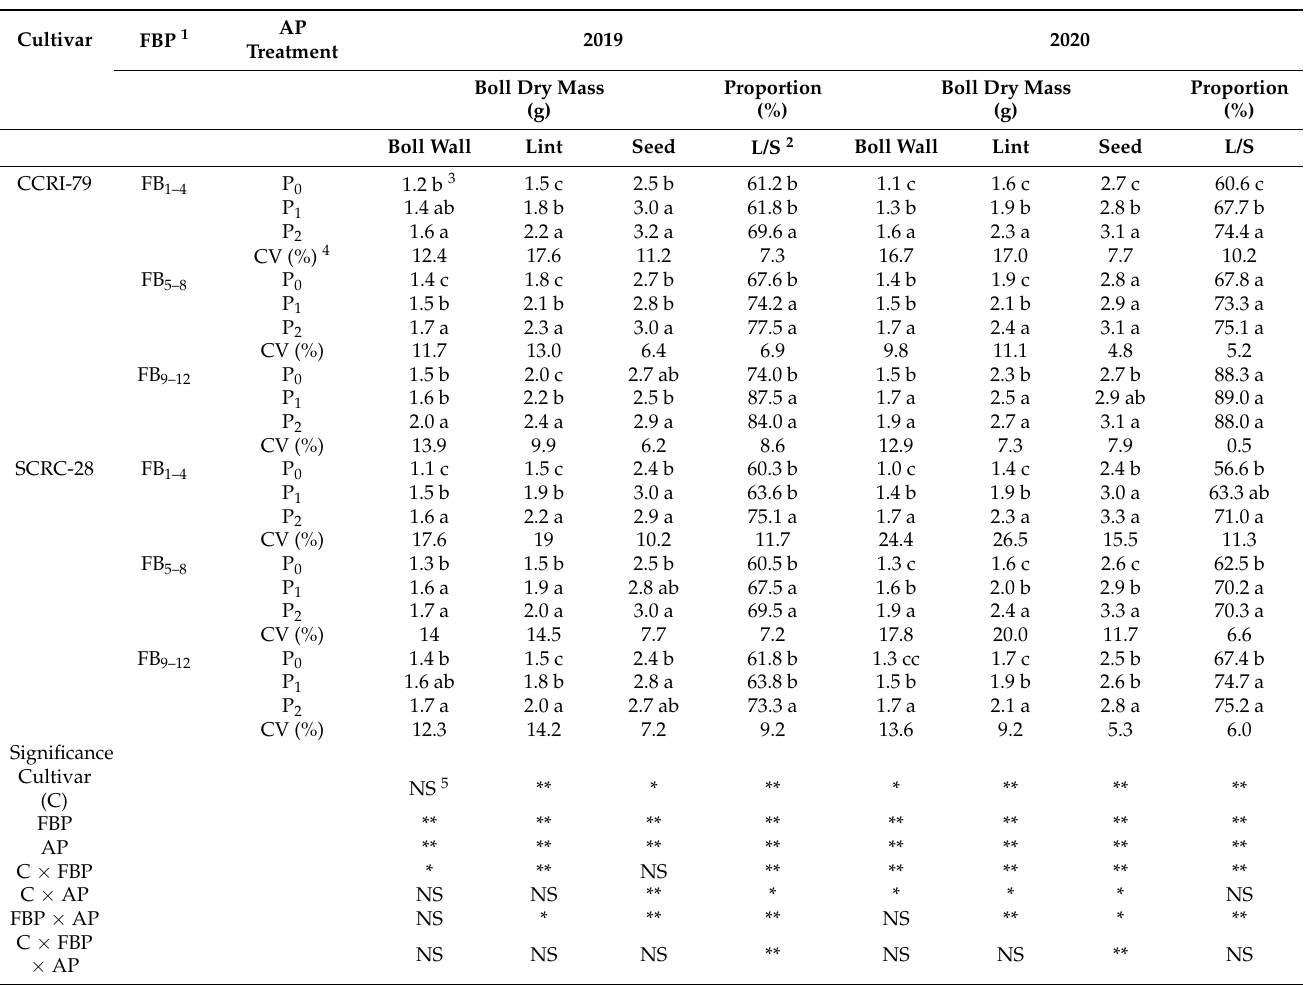
Table 6. The effect of soil available phosphorus (AP) on the cotton boll biomass partitioning across different fruiting branches in 2019 and